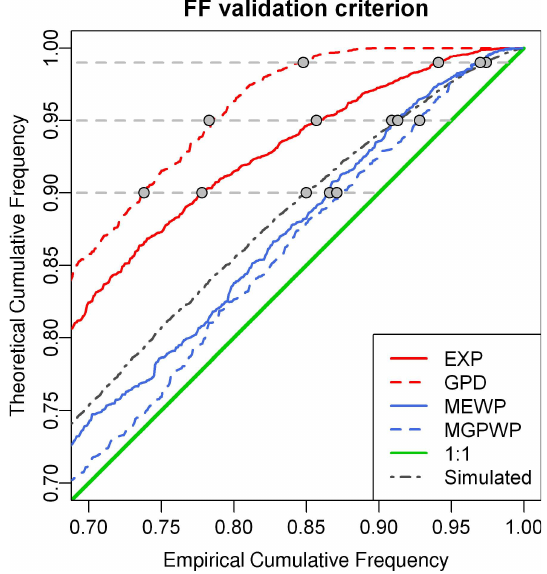
Fig. 7. Close-up of the upper tail of the FF validation procedure. The gray circles highlight the values shown in Table 3. Whole dataset is used to computed these